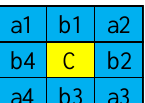
Figure 2. Local 3x3 pixels